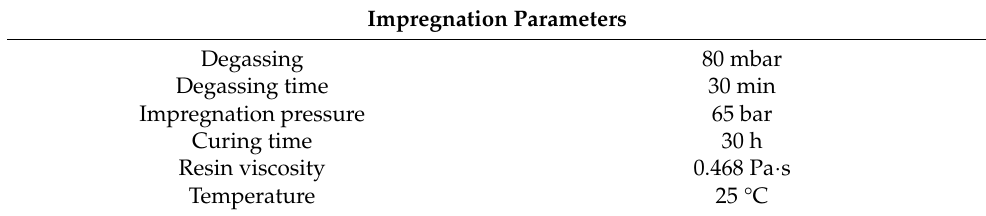
Table 4. Epoxy pore casting of Indiana limestone.